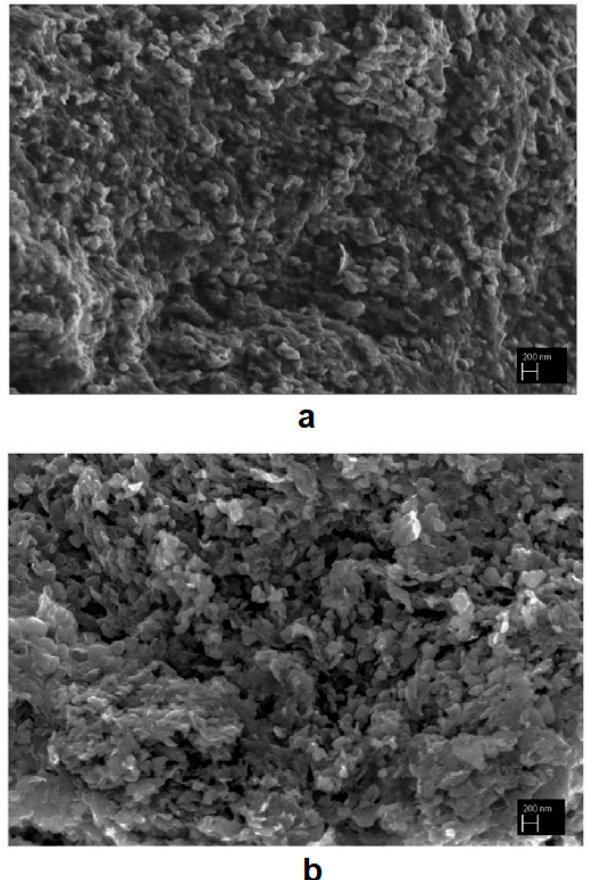
Figure 23. Fracture surface of the compact obtained by SPS of the ball-milled Co-17 wt %C mixture at 800 °C ( a ) and the porous graphitized material obtained by selective dissolution of cobalt from the sintered compact ( b ). Reprinted from Bokhonov et al. [78], Copyright (2018), with permission from Elsevier.